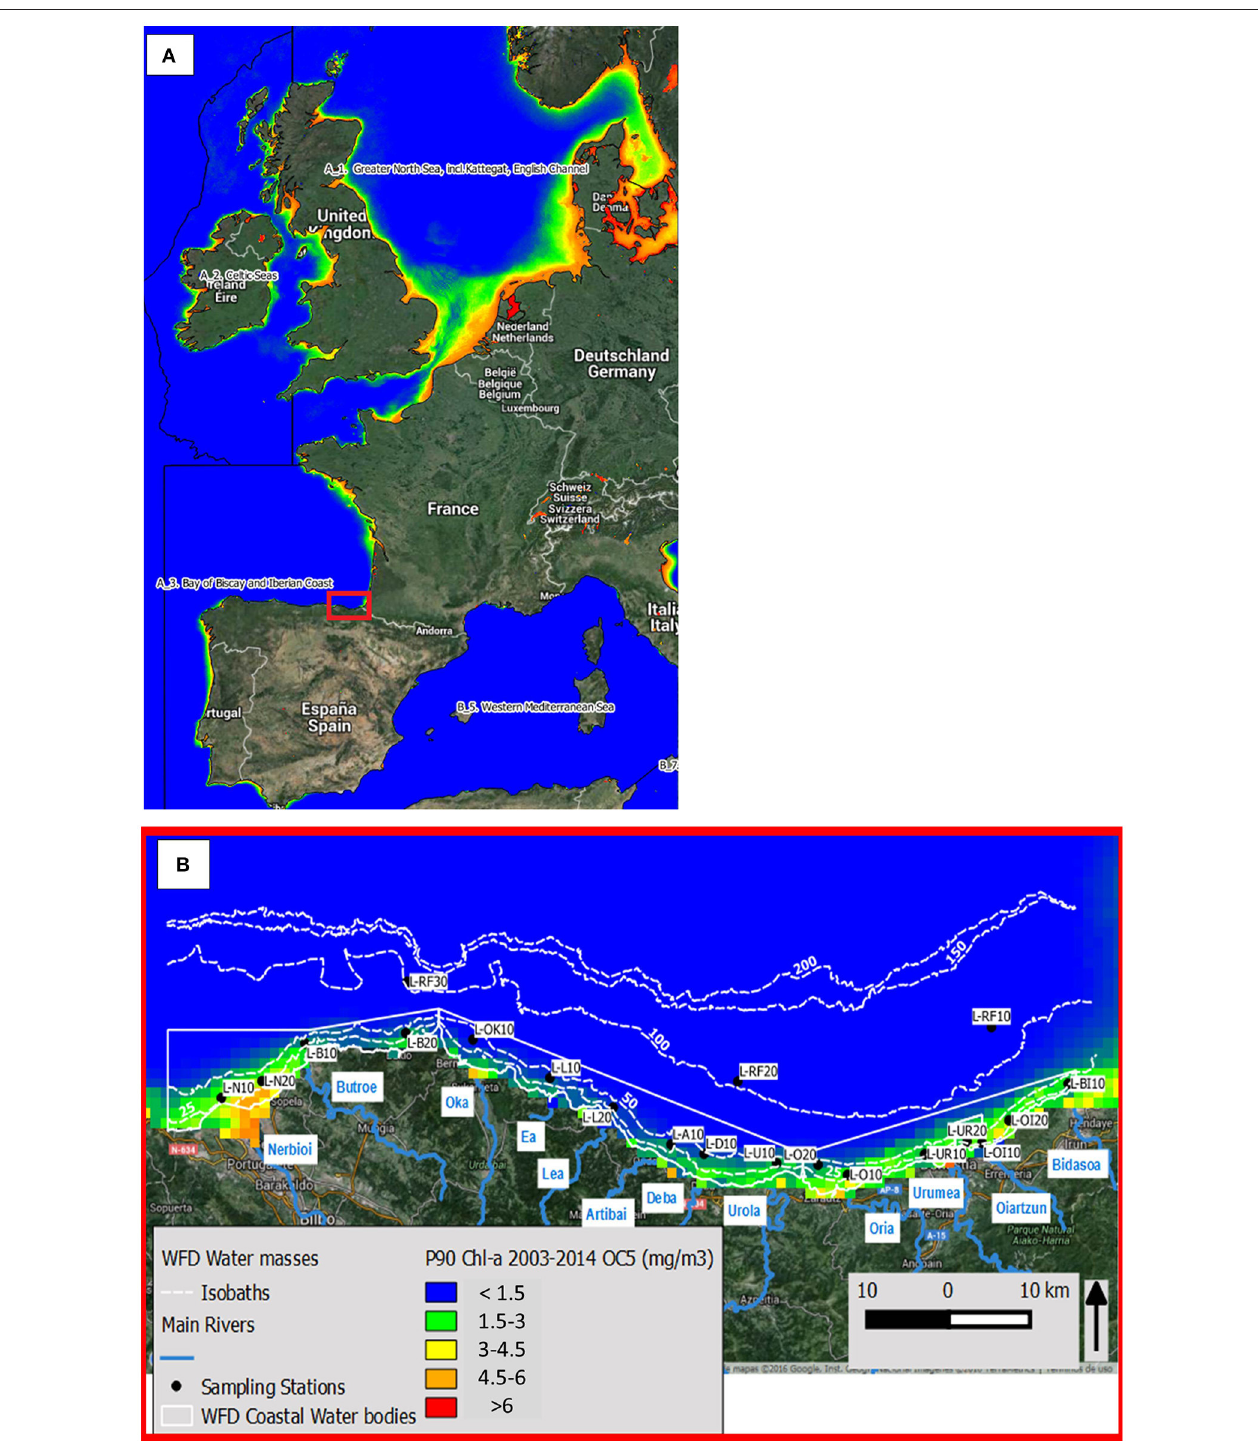
FIGURE 2 | Location of the area of study. (A) Western Europe overlaid with the P90-chla calculated with the MODIS-Aqua OC5 dataset between 2003 and 2013. (B) Detailed information about the location of the sampled stations from the Basque Littoral Monitoring Network, overlaid with main rivers pouring into the coastal zone, WFD water bodies and the P90-chla calculated with the MODIS-Aqua OC5 dataset between 2003 and 2013.